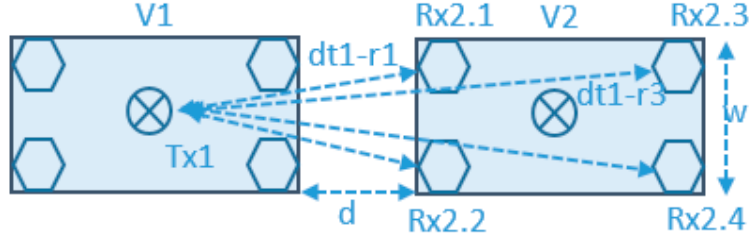
Figure 2. MIMO antennas deployment in V2V-LTE infrastructure.